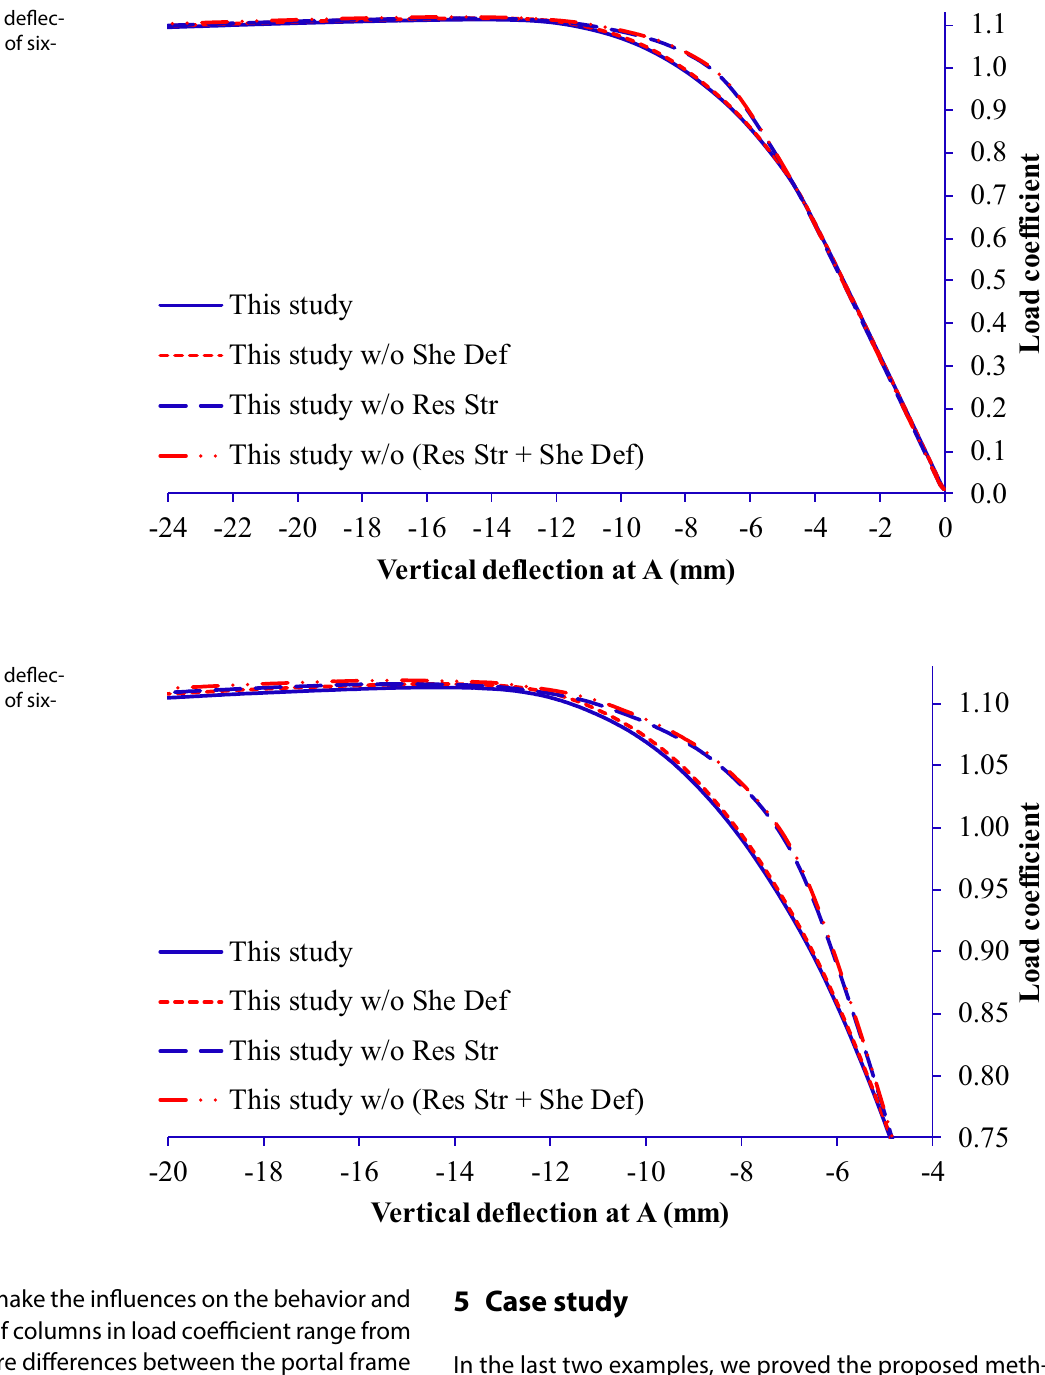
Fig. 14 Load-vertical deflec- tion relationship at A of six- story frame